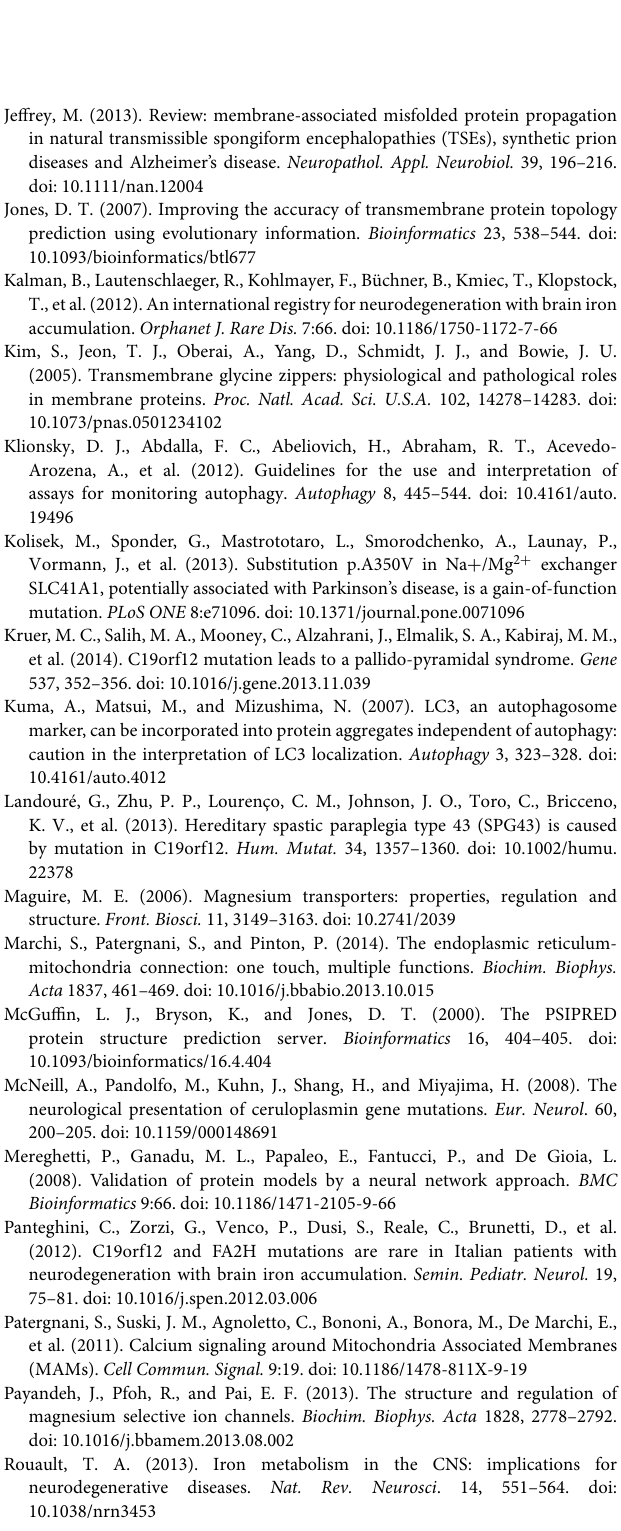
Supplementary Figure 3 | Guide alignment for homology modeling. The sequence alignment between the target (C19orf12) and the template (PDB entry 2yvy, chain A) is shown as derived by the HHPred multiple sequence alignment upon manual correction (see Materials and Methods). “ ∗ ” and “.” indicates identical and similar residues,